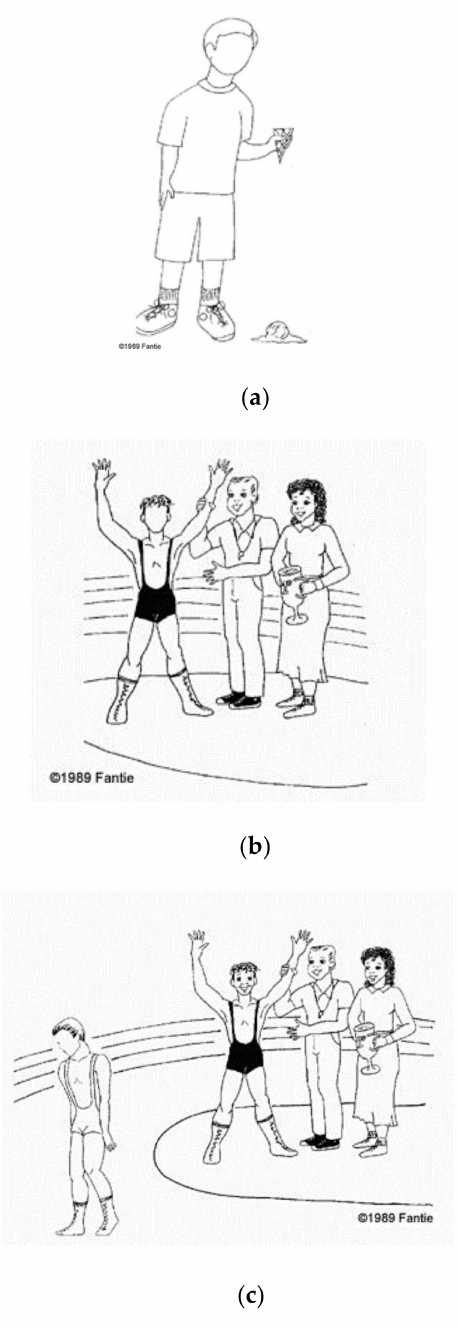
Figure 1. Examples of test items: ( a ) nonsocial context item; ( b ) social congruent context item; ( c ) social noncongruent context